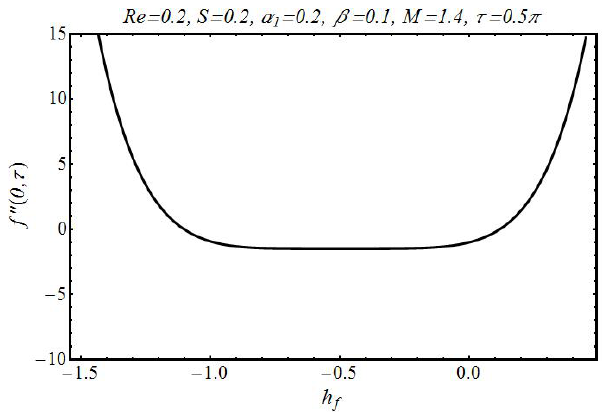
Figure 2: (cid:125) -curve for f ′′ (0, τ ) at 6 th order of approximation.